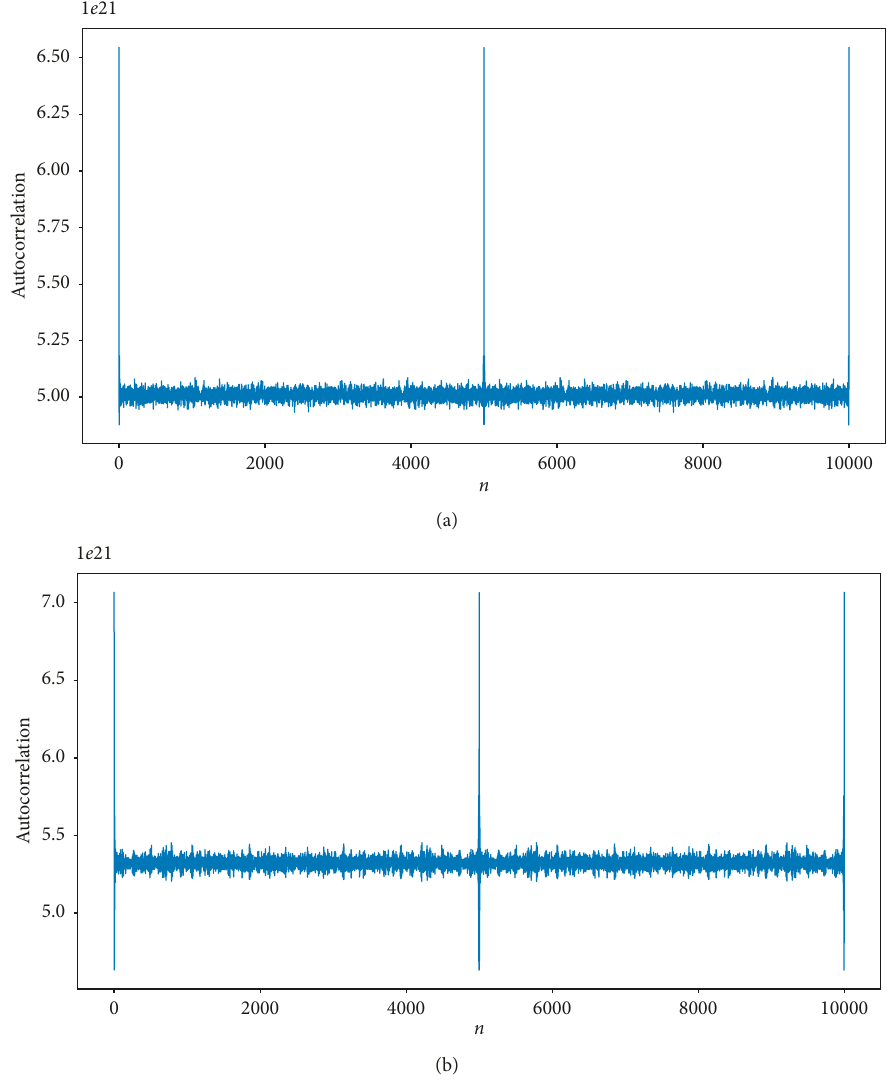
Figure 10: Autocorrelation of CMFSR. (a) Autocorrelation of LMFSR. (b) Autocorrelation of